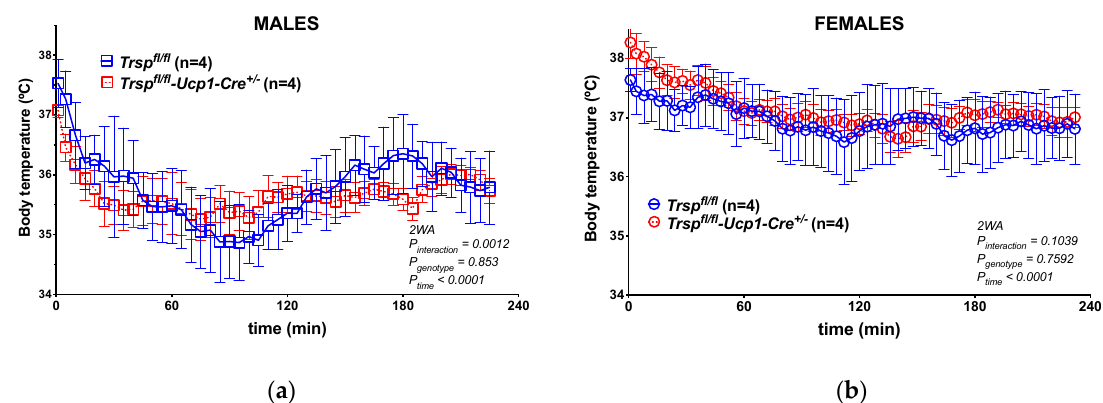
Figure 5. Core body temperature in Trsp f/f and Trsp f/f -Ucp1-Cre +/ − male ( a ) and female ( b ) mice during acute cold exposure. Data are mean ± SD; two-way ANOVA (2WA) with Bonferroni’s post-test was performed, and p -values are displayed in graphs, as well as sample sizes.